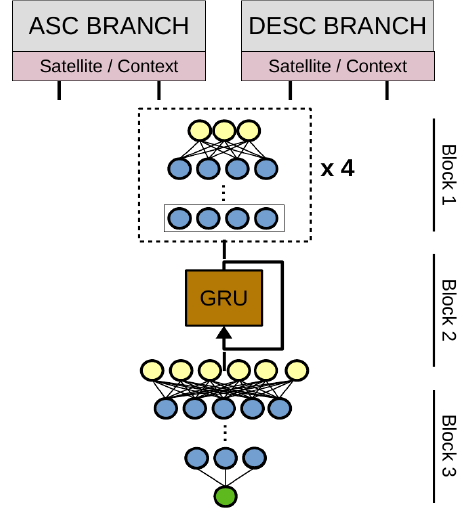
Figure 2. Schematic overview of the proposed SenDVI